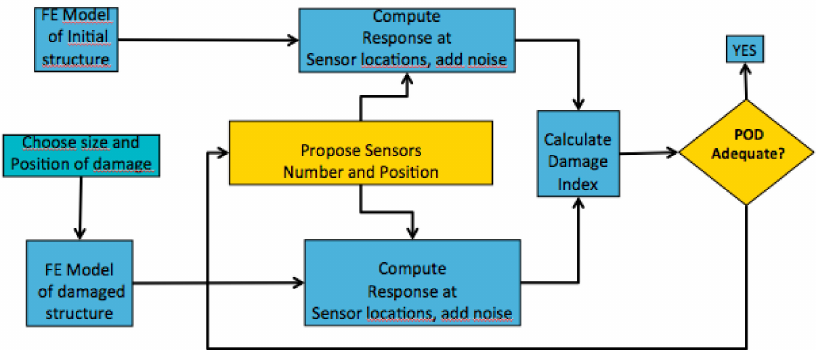
Figure 9. Algorithm used to calculate probability of detection (POD) from strain measurements (reproduced with permission from